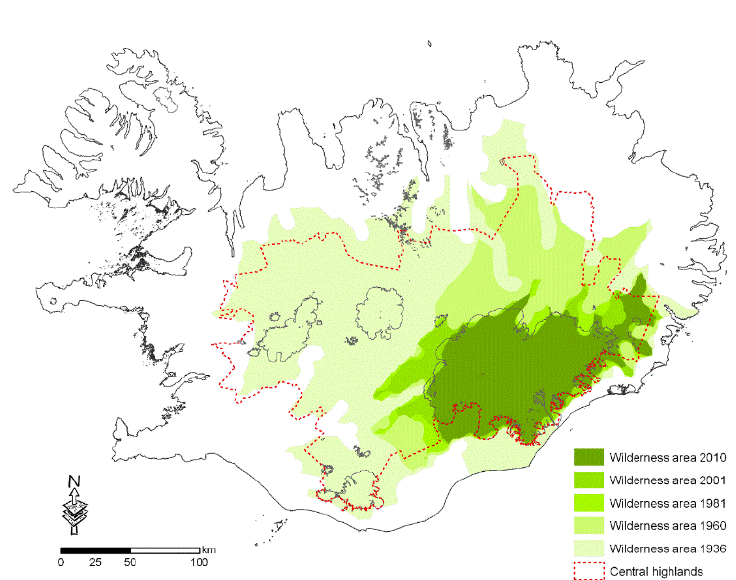
Figure 2. Changes in the scope of the largest total wilderness area in the Icelandic central highlands from 1936–2010 (modified from [28,29]).